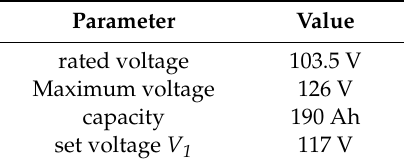
Table 1. Parameters of China Standard EMU battery